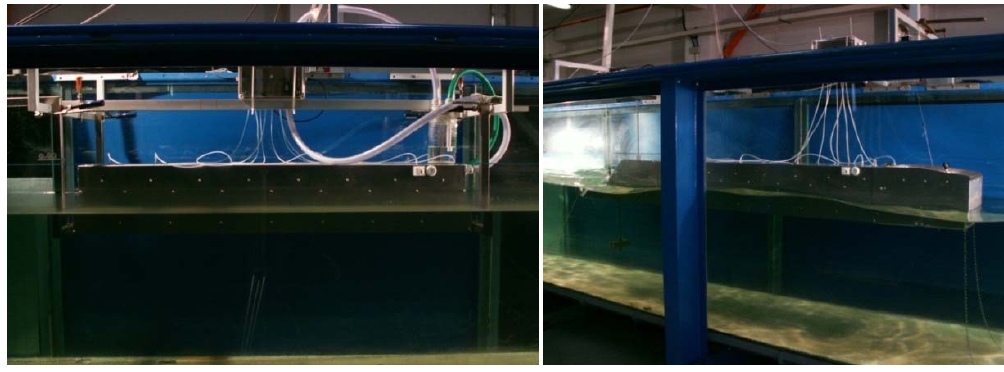
Figure 13. The closed model setup in fixed and floating configuration.